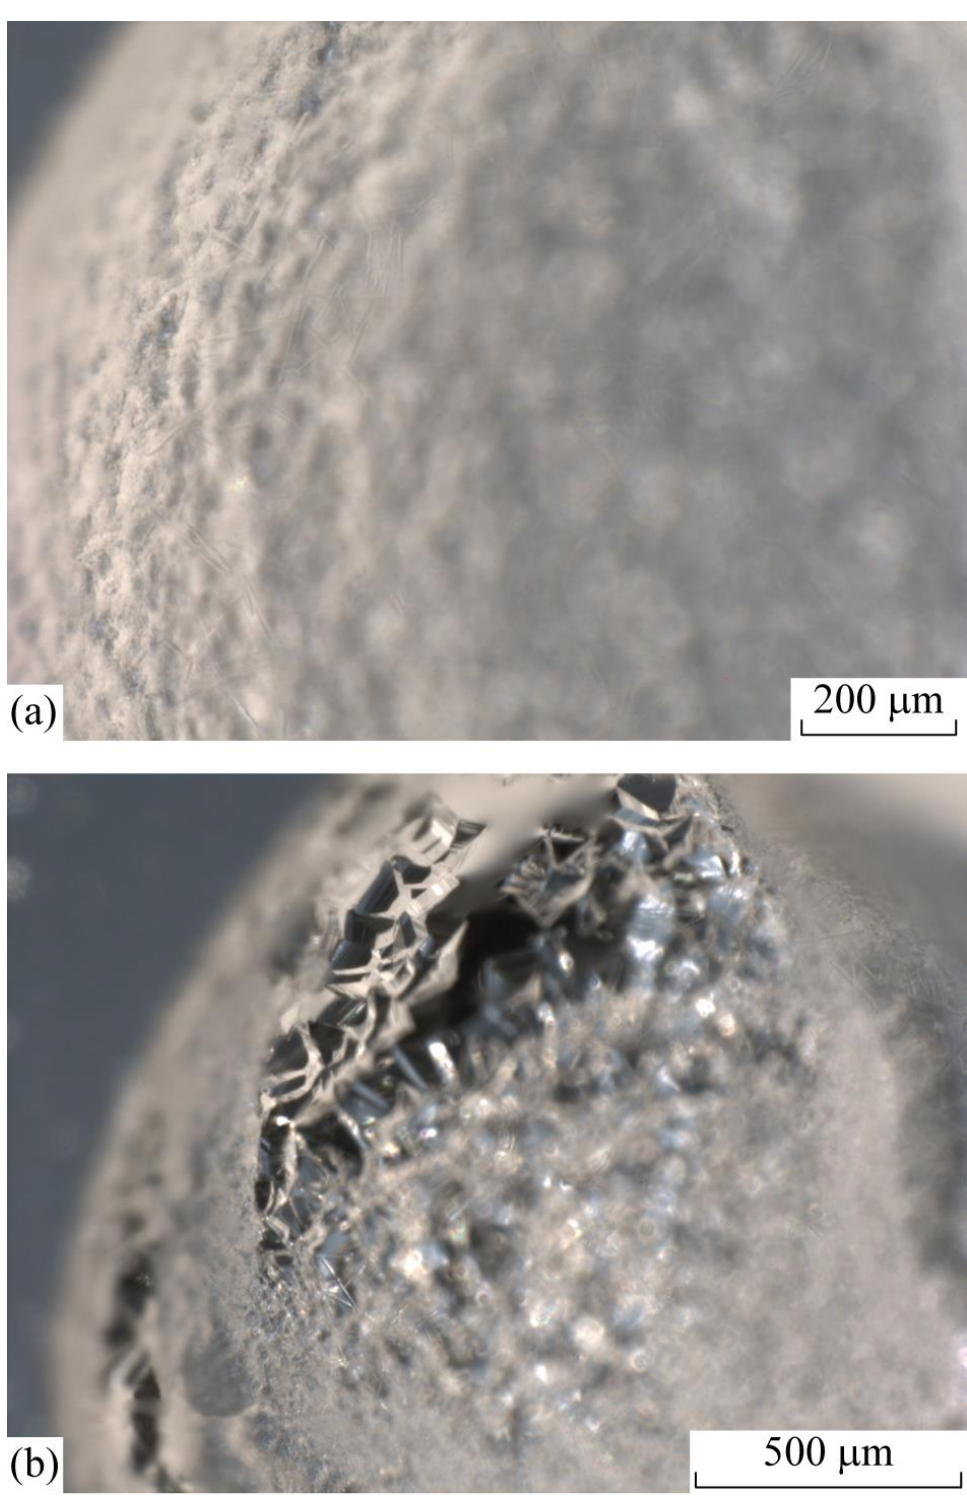
Figure 12. Repeated formation of xenon hydrate after the dissociation of previous sample: ( a ) xenon hydrate (fine-grained form) on the inner surface of a drop before the dissociation; observed at +14 °C, 5 atm; ( b ) formation of xenon hydrate (massive form) on the inner surface of the droplet again within 1 min after the previous melting; observed at +15.5 °C, 5 atm.